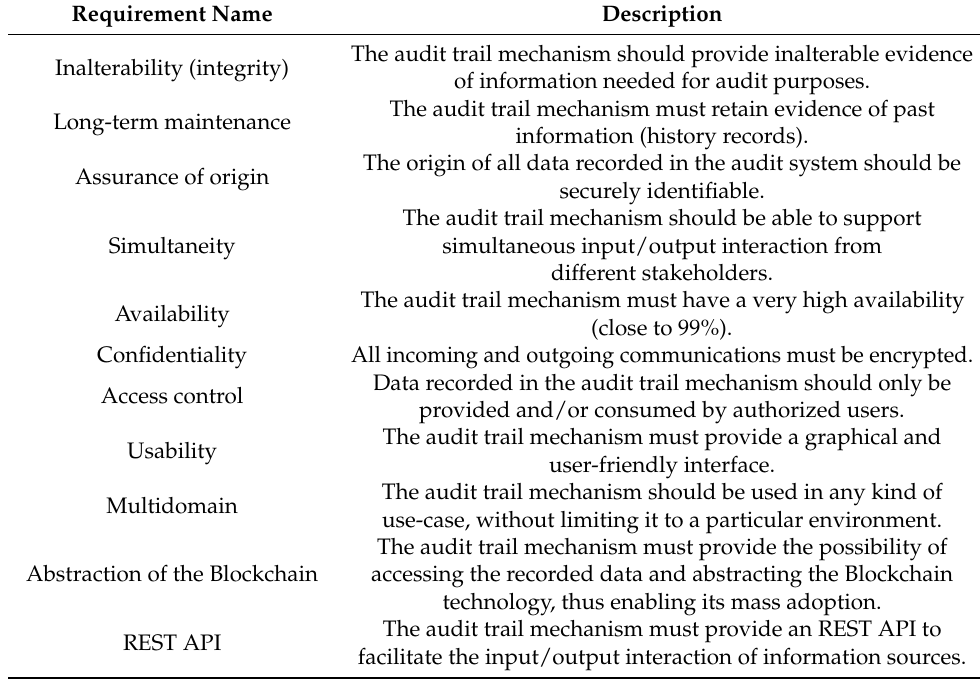
Table 2. Blockchain-based audit trail mechanism